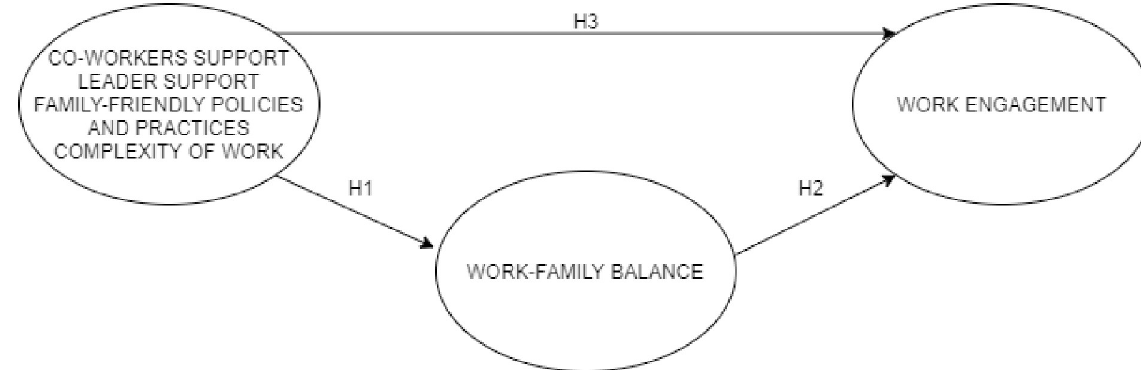
Fig 1. Model of the connection between the elements within the organization, work-family balance and work